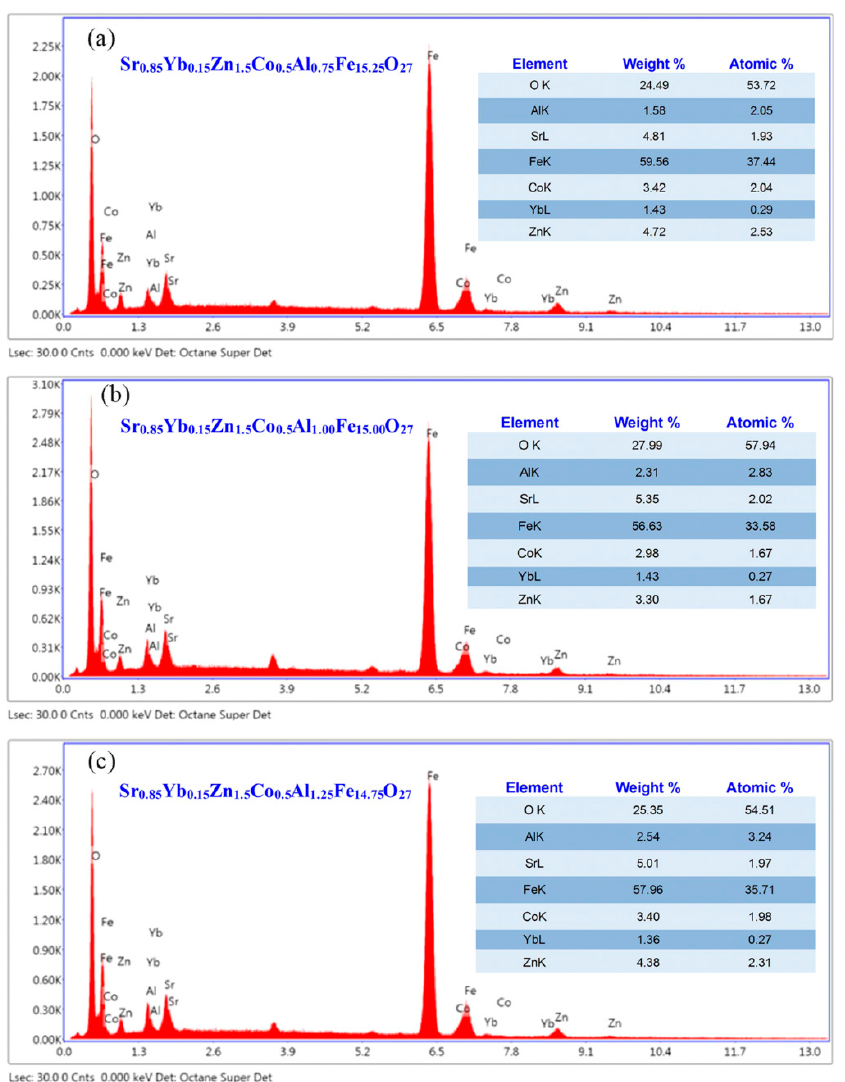
Figure 6. EDX spectra and elemental mapping images of the W-type SrYb hexaferrite Sr 0.85 Yb 0.15 Zn 1.5 Co 0.5 Al x Fe 16 − x O 27 with Al content (x) of ( a ) x = 0.75, ( b ) x = 1.00, and ( c ) x = 1.25.